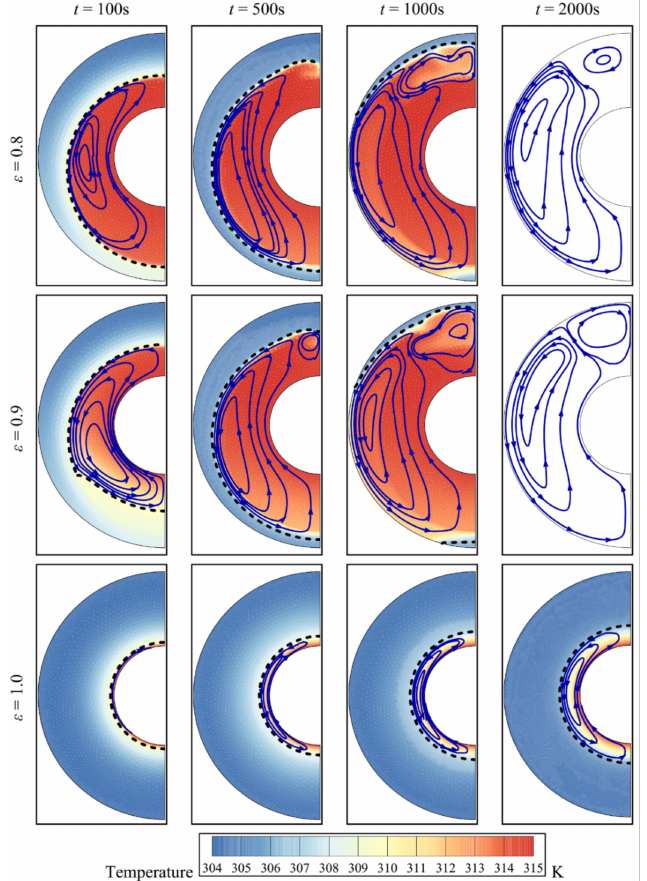
Figure 9. Isotherms, streamline, and melt interface for different porosity values at four charging times for Cu additives with an eccentricity e of 0.12 r s and a volume fraction of nanoparticles σ of